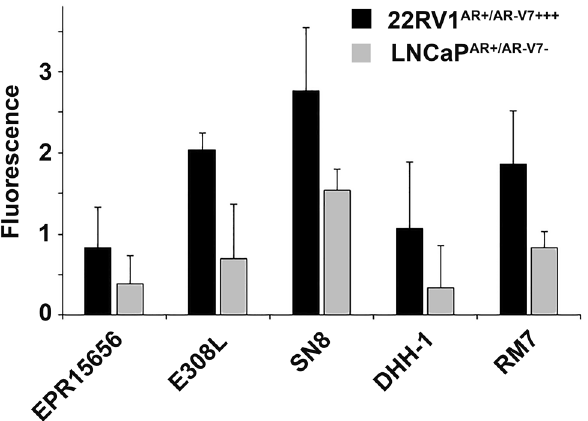
Figure 3. AR-V7 staining nuclear intensity. Cells (imaged as presented in Fig. 2) were segmented using CellProfiler based on identification of Hoechst as a nuclear marker and Alexa fluor 555 phalloidin as a cell body marker. This permitted selective measurement of AR-V7 labelling intensities in individual whole cells, as well as in nuclear and cytoplasmic compartments, per cell. Here, nuclear AR-V7 labelling intensity (average and standard deviation of at least 150 cells per condition) is depicted after normalisation to control values (no primary antibody labelling), allowing comparison of antibody signals in 22RV1 AR+/AR−V7+++ and LNCaP AR+/AR−V7− cells. Fluorescence (Y-axis): in arbitrary units.